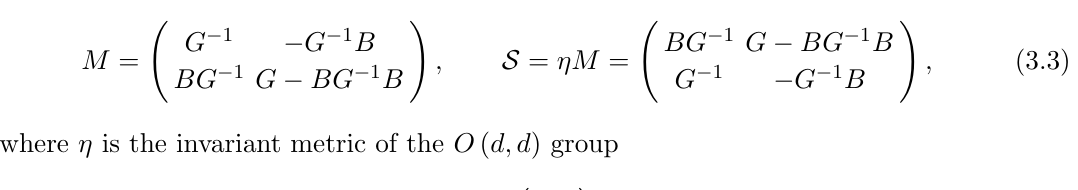
Figure 1 . The evolutions of the Hubble parameters of four solutions (we set d = 3 in this plot).